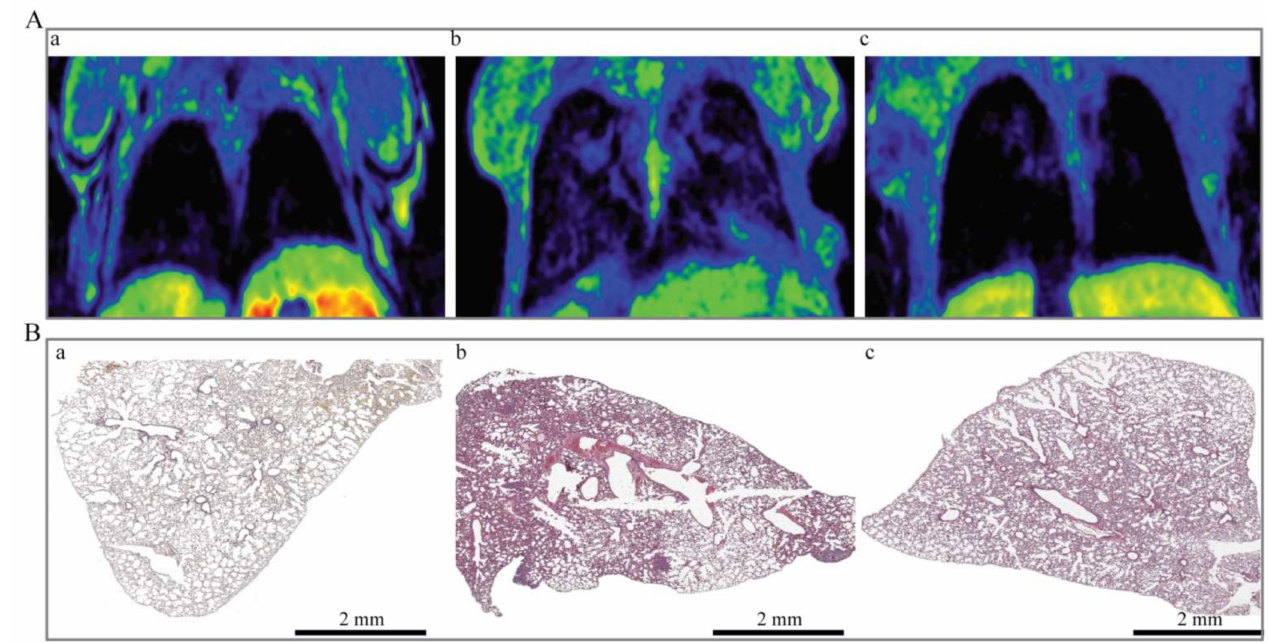
Figure 5. Metastatic investigation of lungs. ( A ) MRI images, ( B ) HE staining. ( a ) Healthy mice; ( b ) Tumor-bearing mice treated with Gadovist; ( c ) Tumor-bearing mice treated with Mn-CDs-NHF. Individual pictures acquired at 10 × were used to rebuild the image of the lung